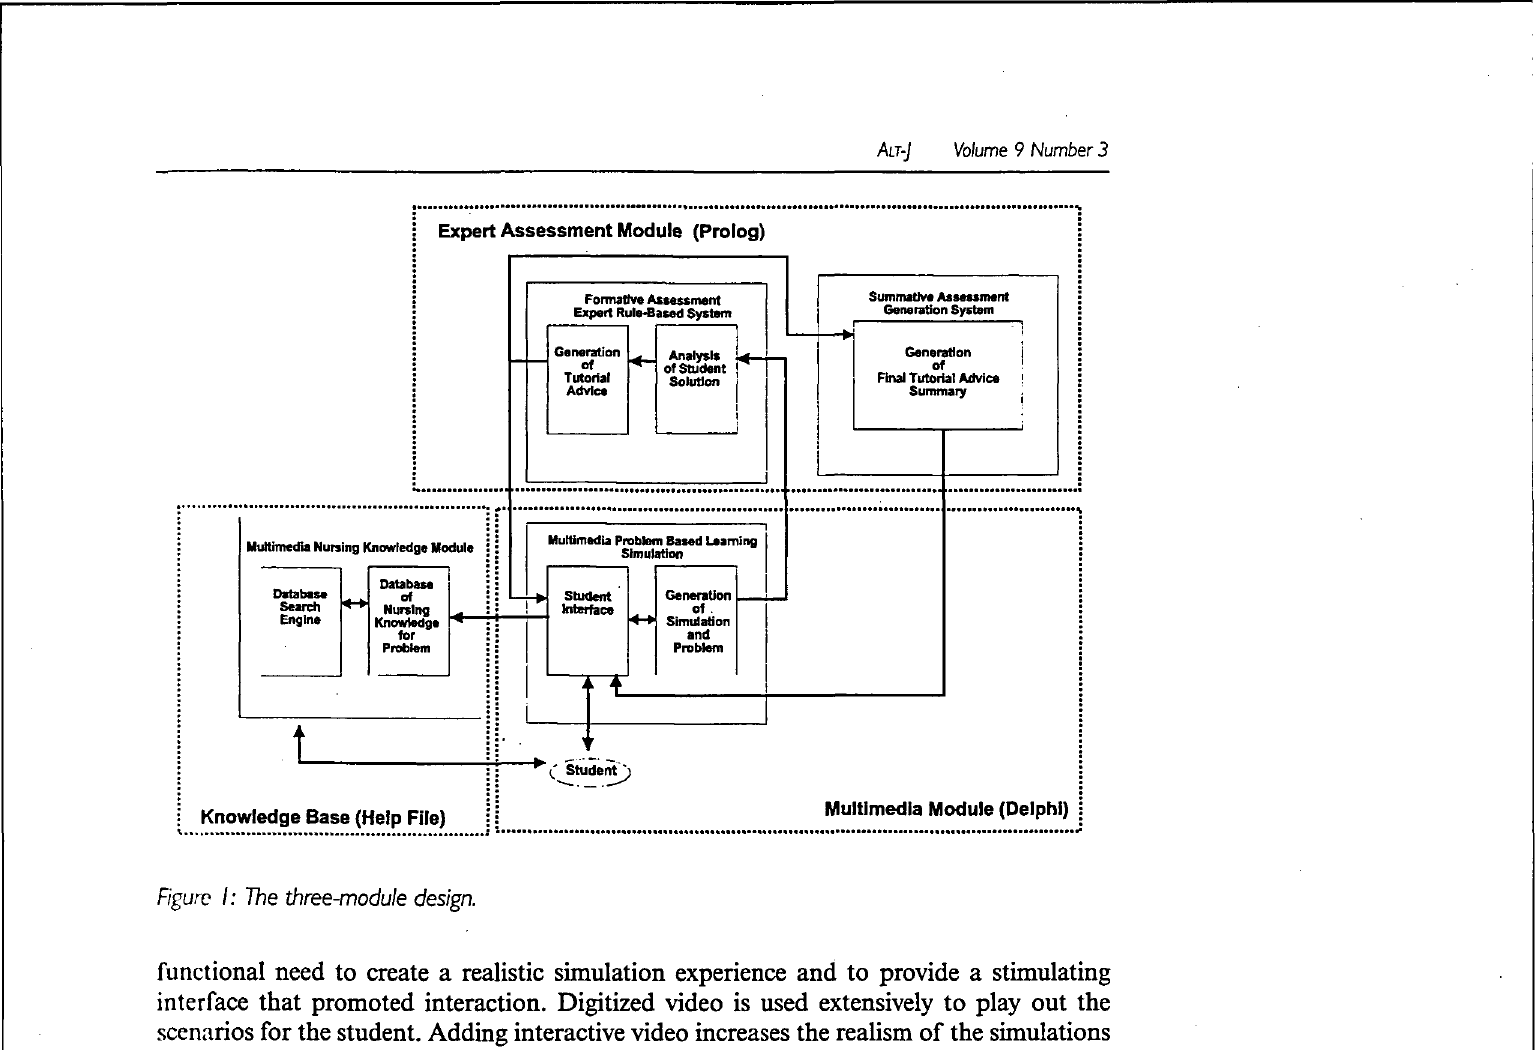
Figure I: The three-module